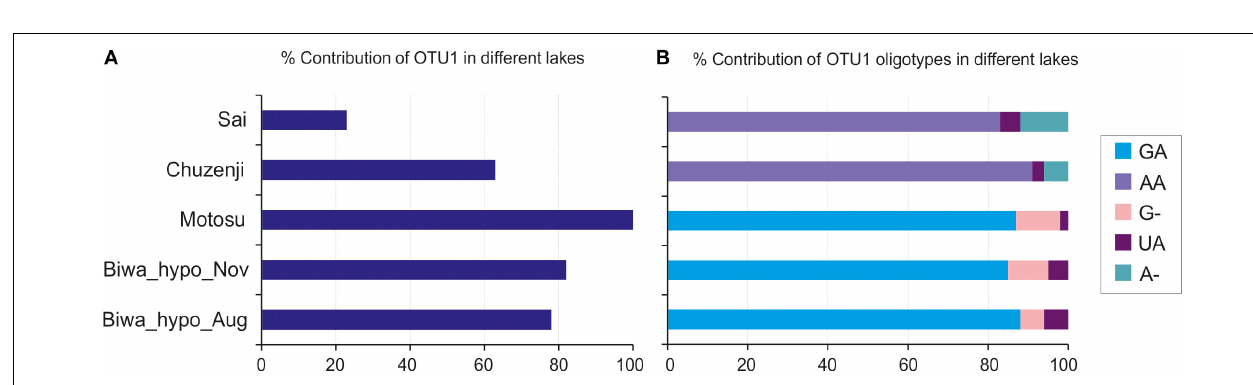
Frontiers in Microbiology |